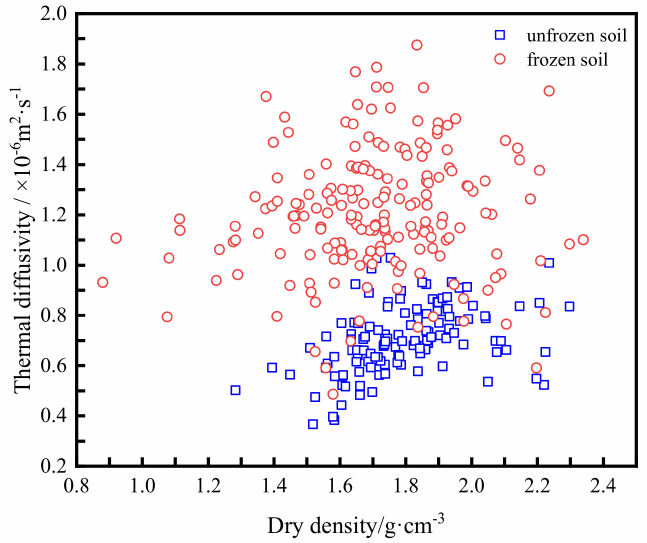
Figure 8. Distribution relationship between dry density and thermal diffusivity.